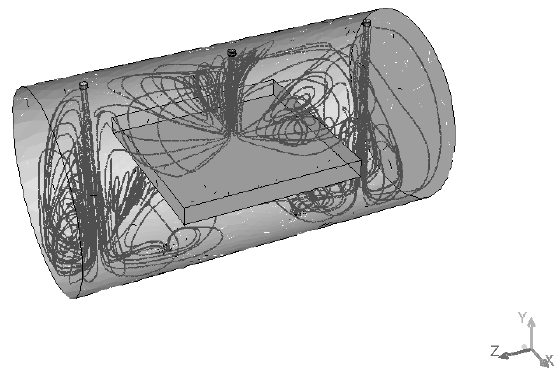
Figure 11. Path lines starting from inlets (The Figure is prepared with the outer face cut to show boundary surfaces and internal area at the same